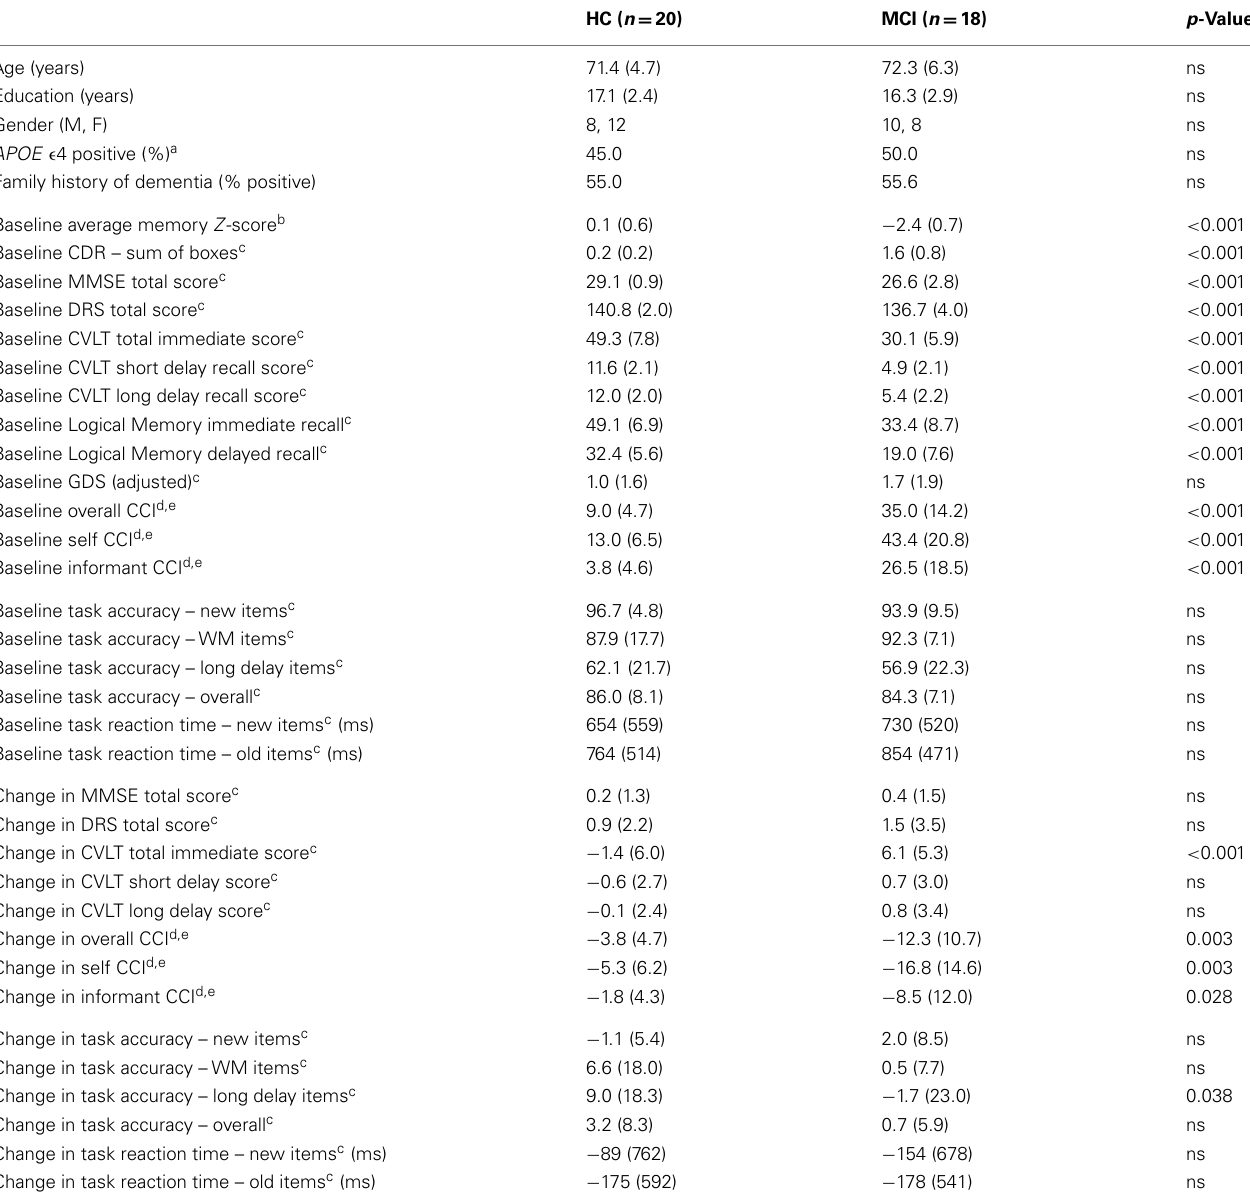
Table 1 | Demographic information and neuropsychological